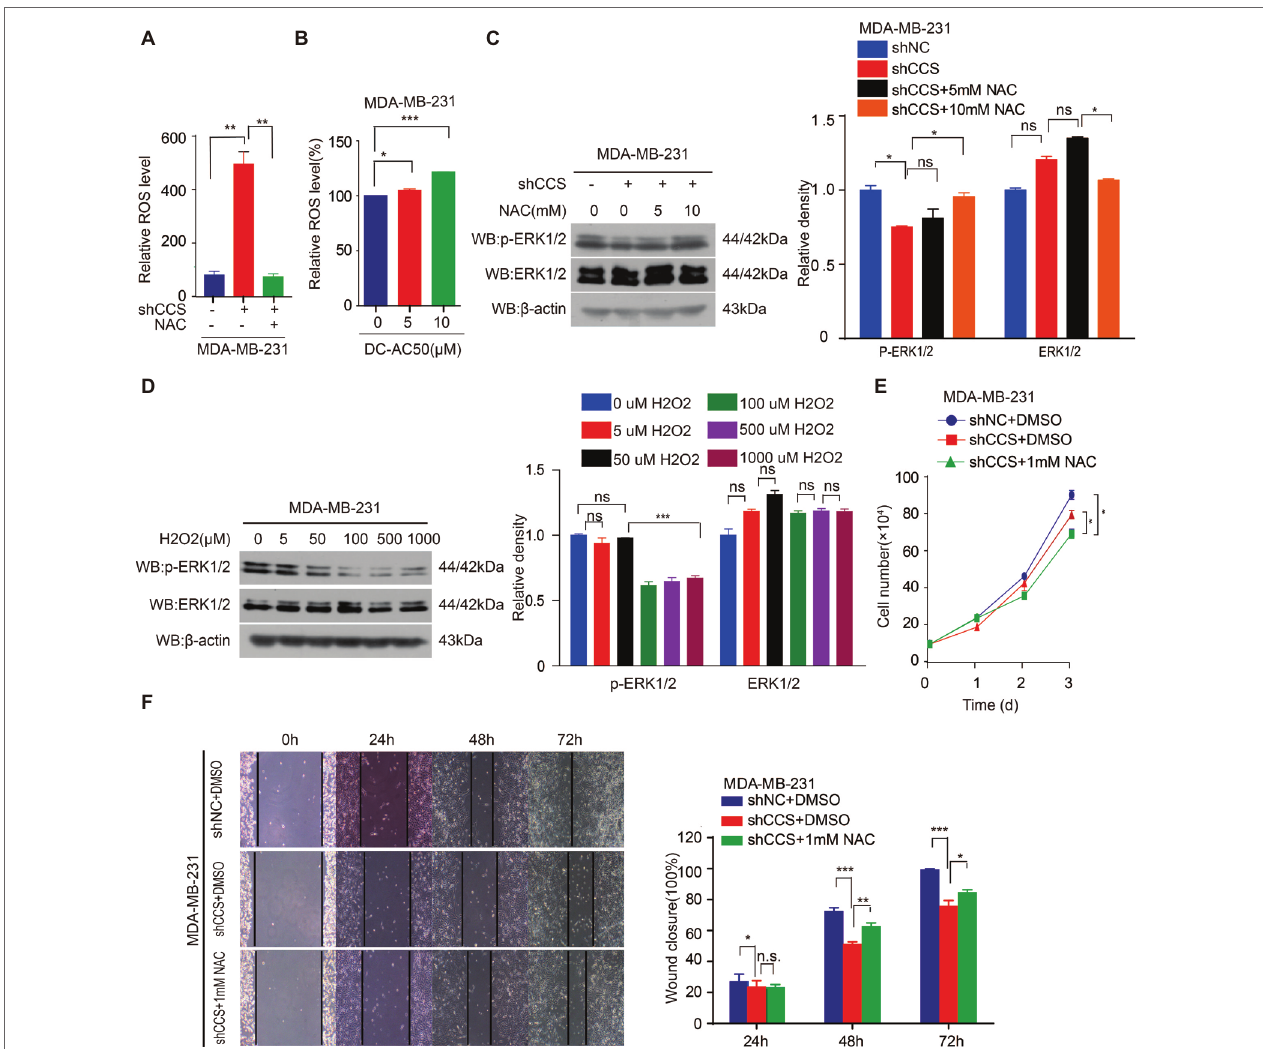
FIGURE 5 | CCS promotes breast cancer cell migration and cell proliferation via ERK1/2 activity mediated by ROS. (A) Knockdown of CCS increased ROS level in MDA-MB-231 cells, which was rescued by treatment with 1 mM NAC. (B) Treatment with DC_AC50 (5, 10 μM) induced ROS elevation in MDA-MB-231 cells. (C) Western blot analysis of total and phosphorylated ERK1/2 levels. β -actin was used as a loading control. Reduced ERK1/2 activity by CCS knockdown was rescued by treatment with NAC (5, 10 mM) for 12 h. (D) H 2 O 2 significantly abolished ERK1/2 activity in MDA-MB-231cells after 12 h. (E) Cell proliferation